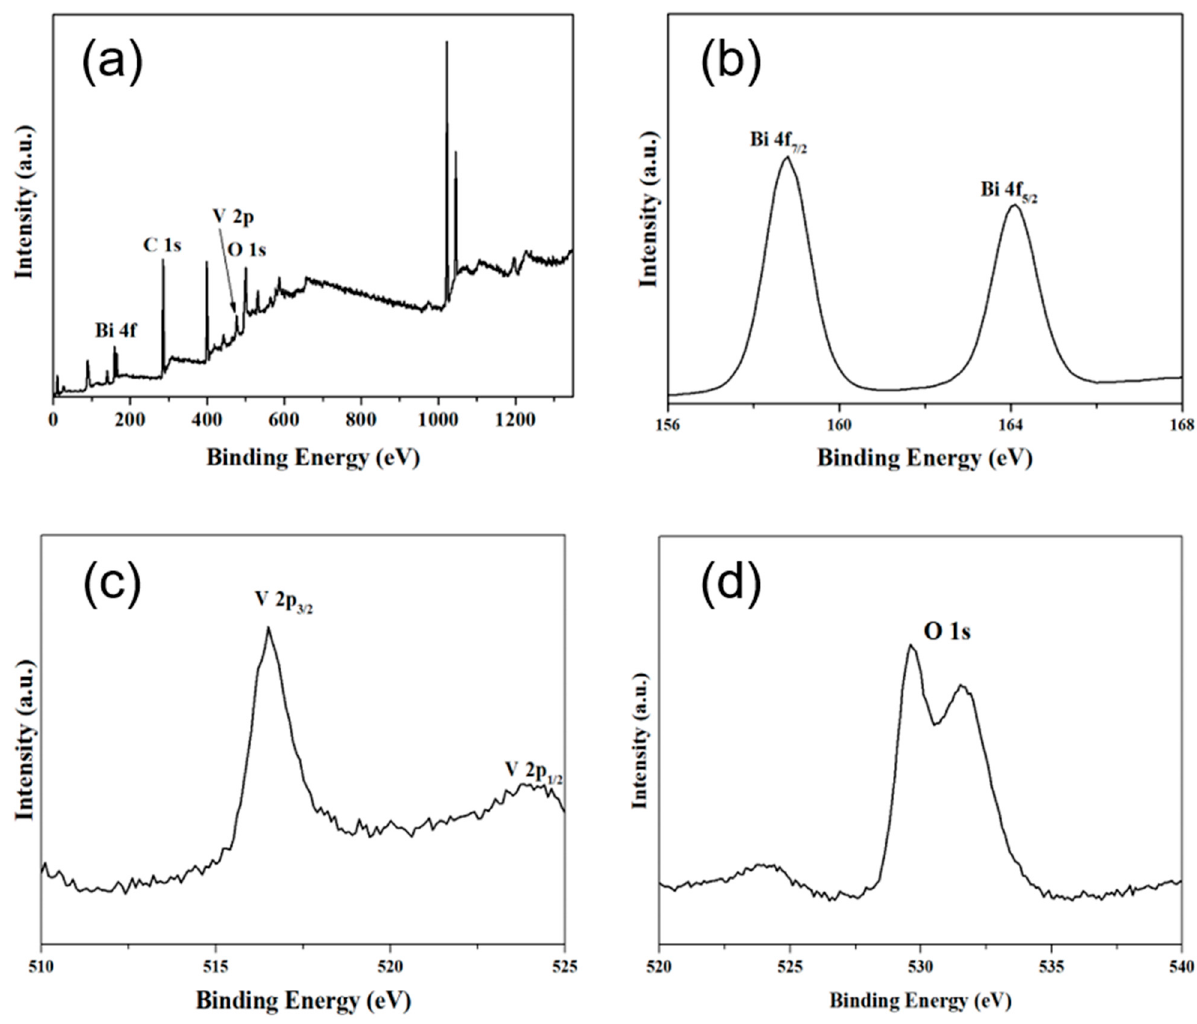
Figure 3. ( a ) XPS spectra of BiVO 4 showing the presence of Bi, C, O and V. High-resolution XPS spectra showing: ( b ) Bi 4f at 158.5 and 164.4 eV, ( c ) V 2p 516.5 eV and 524.3 eV and ( d ) O 1s at 528.9 and 532.5 eV.